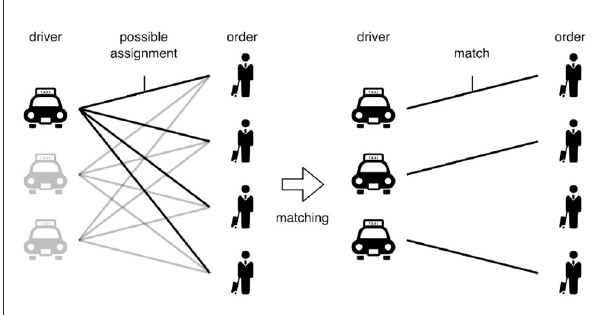
FIGURE1 Global optimization task on bipartite graphs for the transportation domain. Out of possible driver–order assignments, pairs among drivers and orders are decided in terms of some global metric (e.g., total